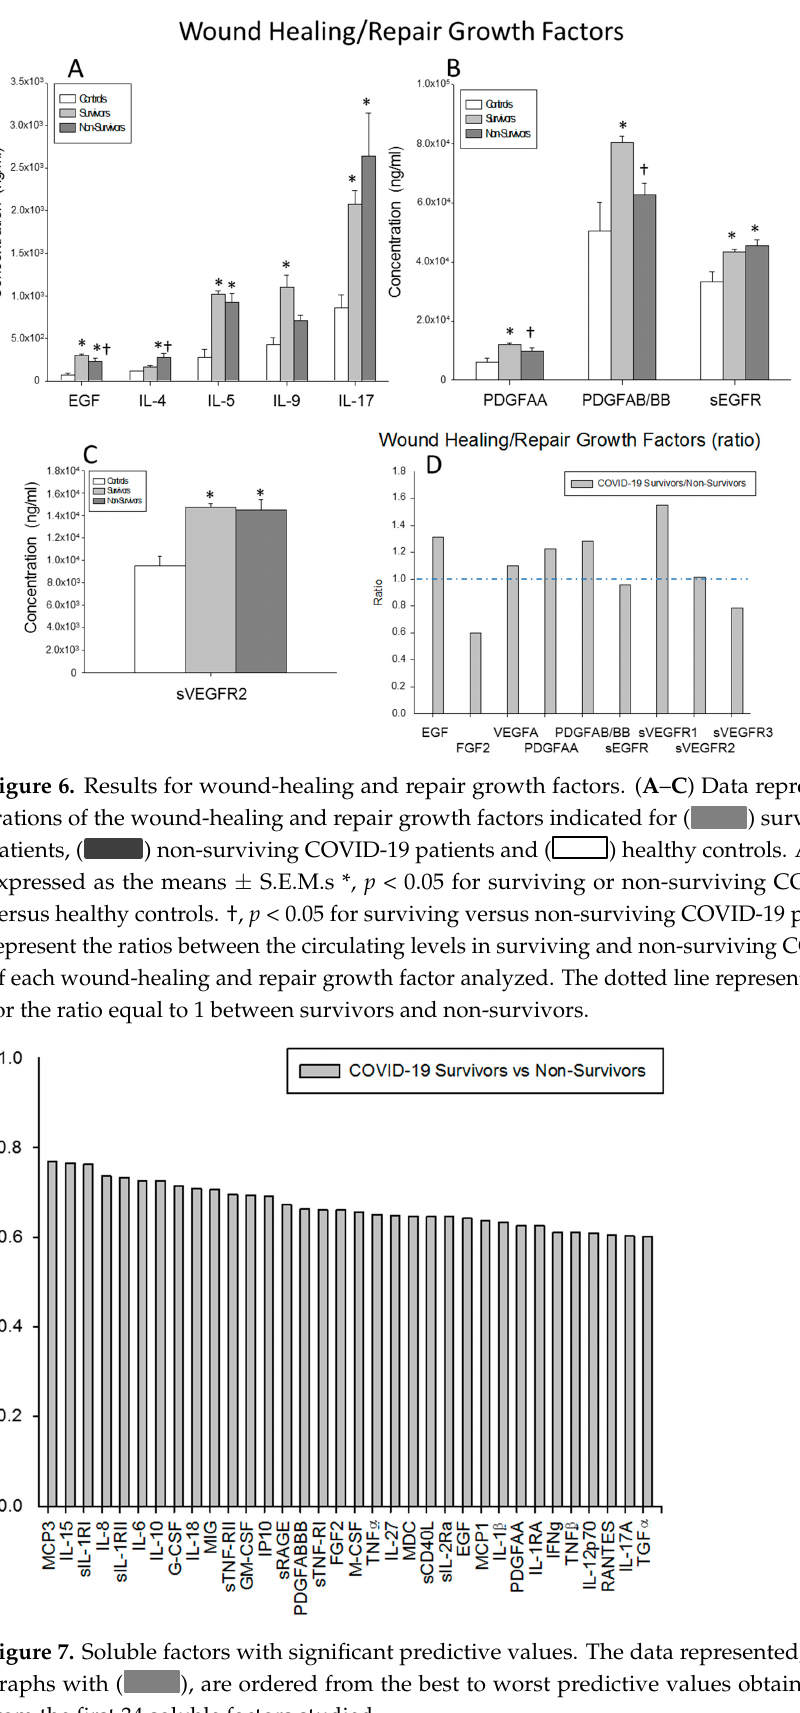
Int. J. Mol. Sci. 2022 , 23 , 10344 10 of 22 The ratios of the serum concentrations of IL-3, GM-CSF and G-CSF were increased in the survivors compared to the non-surviving severe COVID-19 patients. By contrast, the ratios of IL-2, Il-7 and M-CSF were reduced in the survivors (Figure 4C). 2.5. Serum Levels of Cytokines Involved in the Adaptive Immune System Response We investigated the circulating levels of IFN γ , IL-4, sIL-4R, IL-5, IL-9, IL-17A, IL-17F, IL17-E/25, IL-22 and sCD30 in surviving and non-surviving severe COVID-19 patients and healthy controls. The IFN γ IL-17A and sIL-4R levels were significantly reduced in the survivors compared to the non-survivors ( p = 0.020 p = 0.029 and p = 0.049, respectively). The IFN γ , IL-4 and sIL-4R serum levels were significantly enhanced in both groups of patients compared to the healthy controls (surviving patients vs. controls: p = 0.004, p = 0.001 and p <0.0001, respectively; non-surviving vs. controls: p = 0.001, p = 0.001 and p < 0.0001, respectively). In addition, the IL-9, IL-17A and IL-17F serum levels were signifi- cantly increased in the non-survivors compared to the healthy controls ( p = 0.008, p = 0.030 and p = 0.019, respectively) (Figure 5A,B).